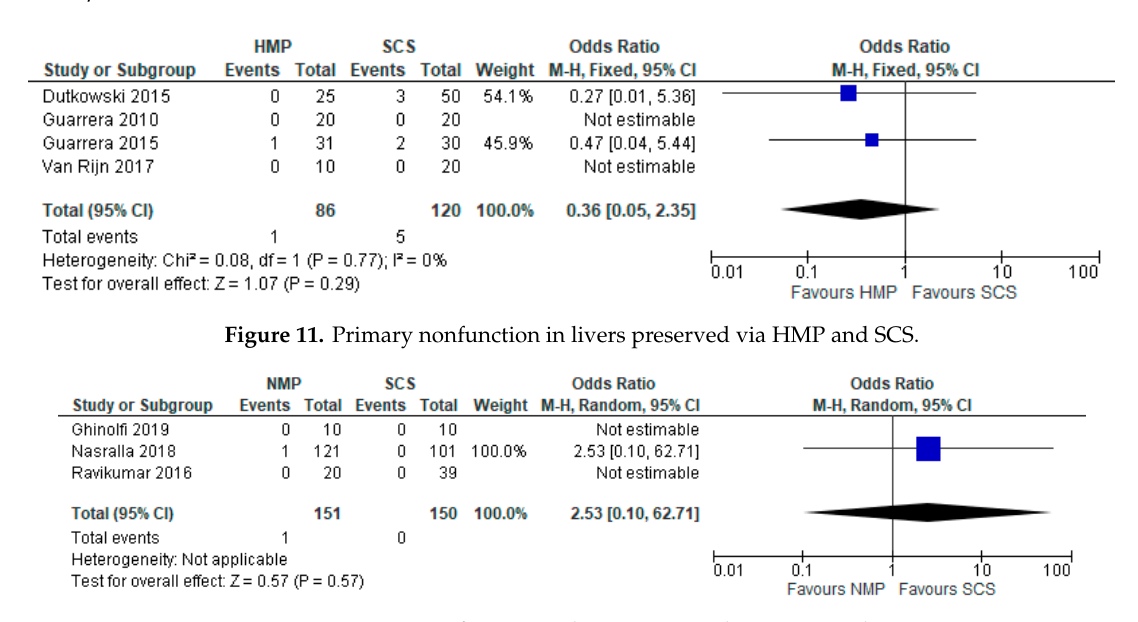
Figure 12. Primary nonfunction in livers preserved via HMP and SCS.